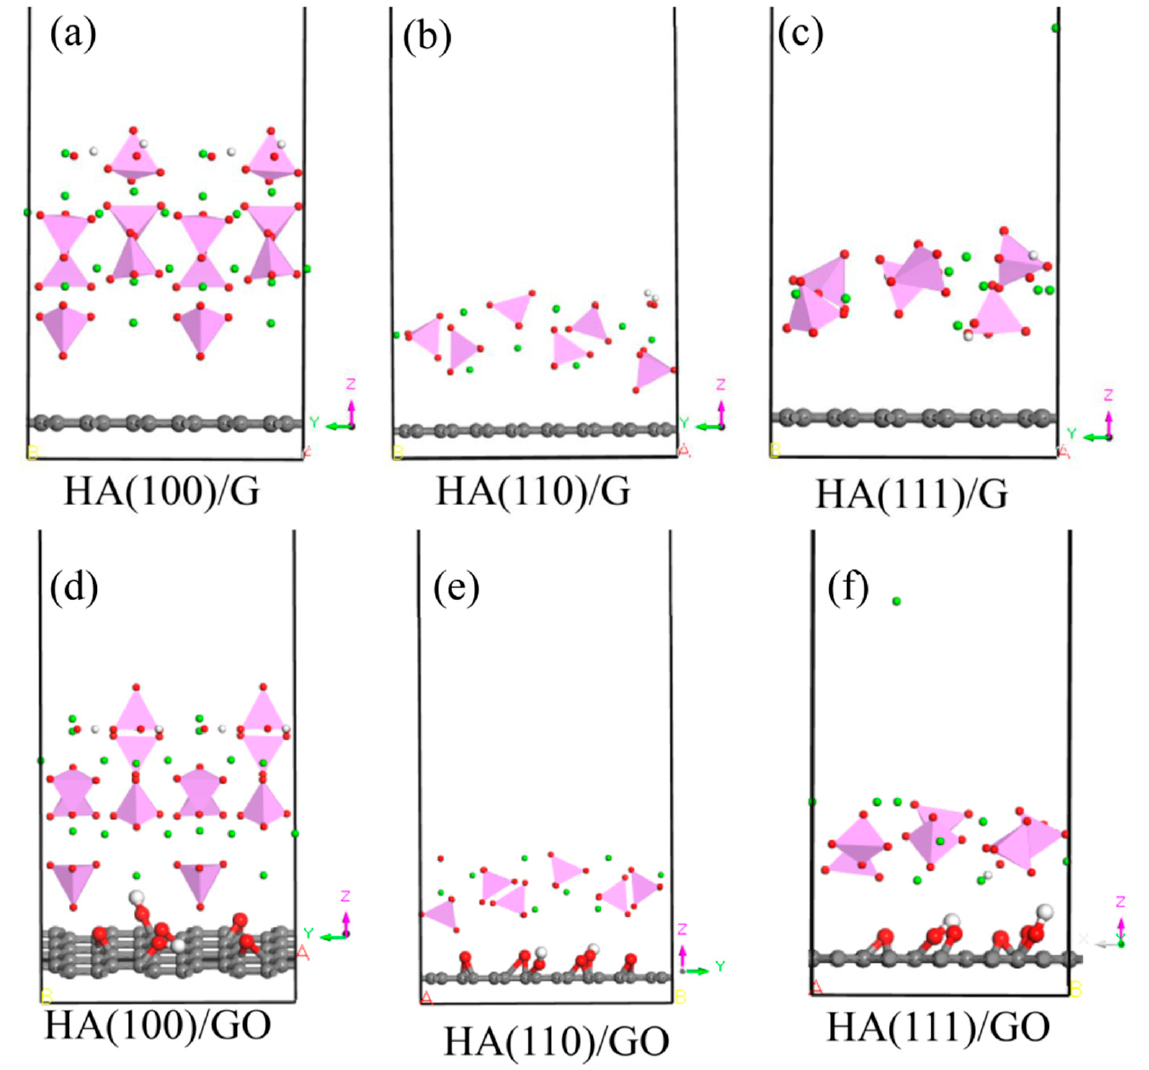
Figure 2. Supercrystal cell modes of HA with G and with GO in different crystal planes (the atom colors are the same as in Figure 1. ( a ) HA(100)/G, ( b ) HA(110)/G, ( c ) HA(111)/G, ( d ) HA(100)/GO, ( e ) HA(110)/GO, ( f ) HA(111)/GO.